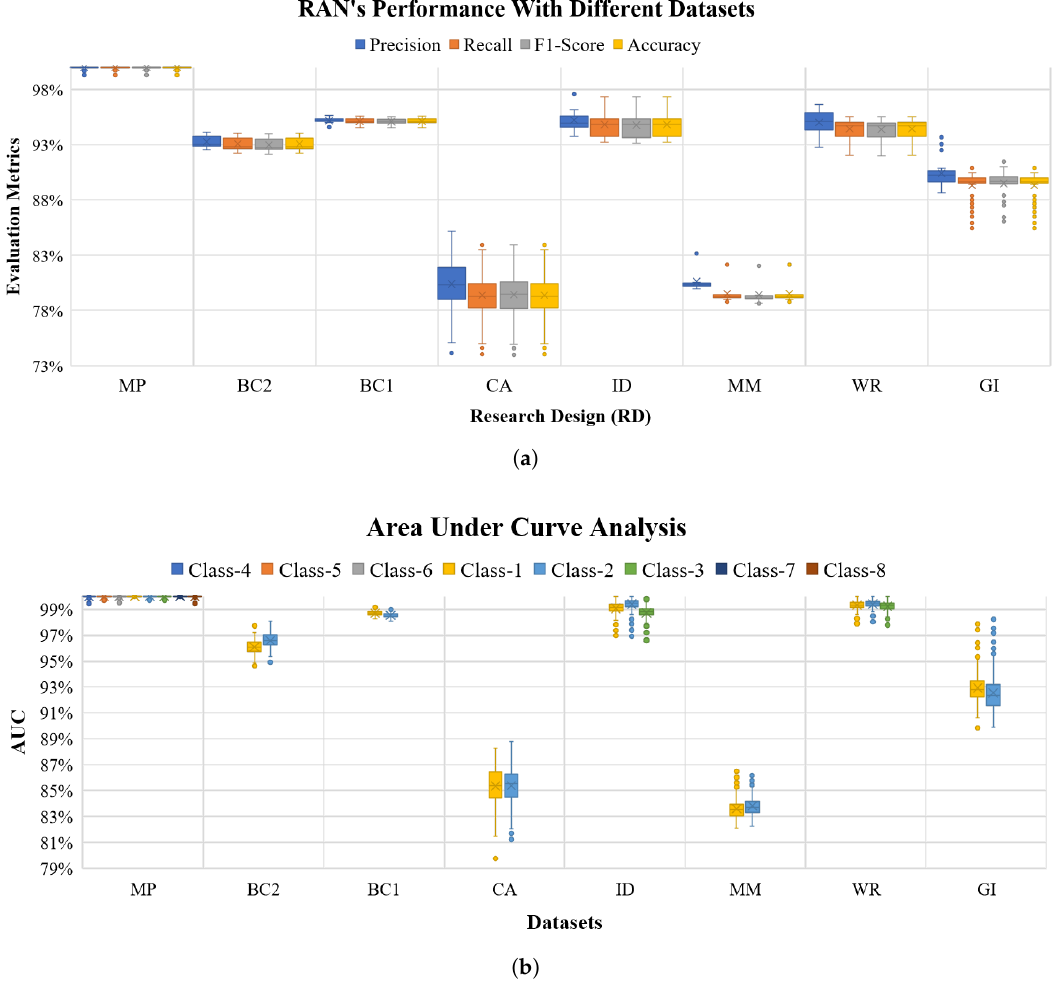
Figure 11. RANs performance with eight datasets using Precision, Recall, F1-Score and Accuracy along with ROC-AUC analysis with Eight benchmark datasets [Mice Protein (MP), Breast Cancer 669 (BC1), Breast Cancer 569 (BC2), Credit Approval (CA), IRIS data (ID), Mamographic Mass (MM), Wine Recognition (WR) and Glass Identification (GI)]. ( b ) shows the plot of percentage AUC for classes 1 to 8. For each dataset class labels of the graph is serially mapped as: Mice protein ( c-CS-s [Class-1],